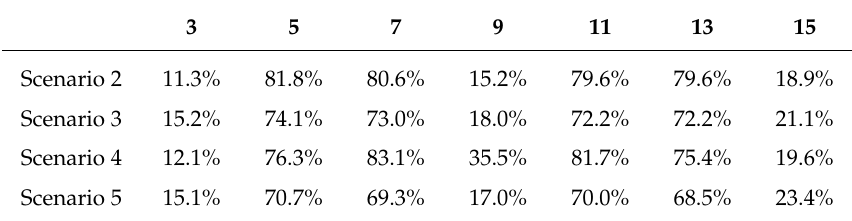
Table 6. Ratio of reduction of normalized harmonic currents between 11 and 126 users.